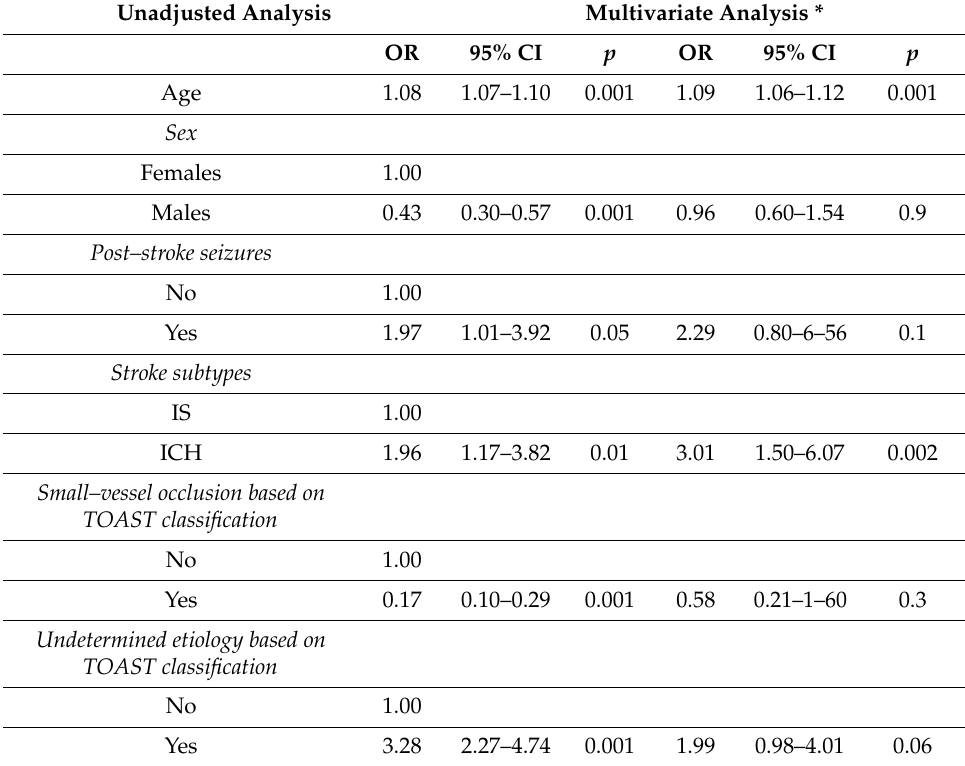
Table 2. Predictors of long-term